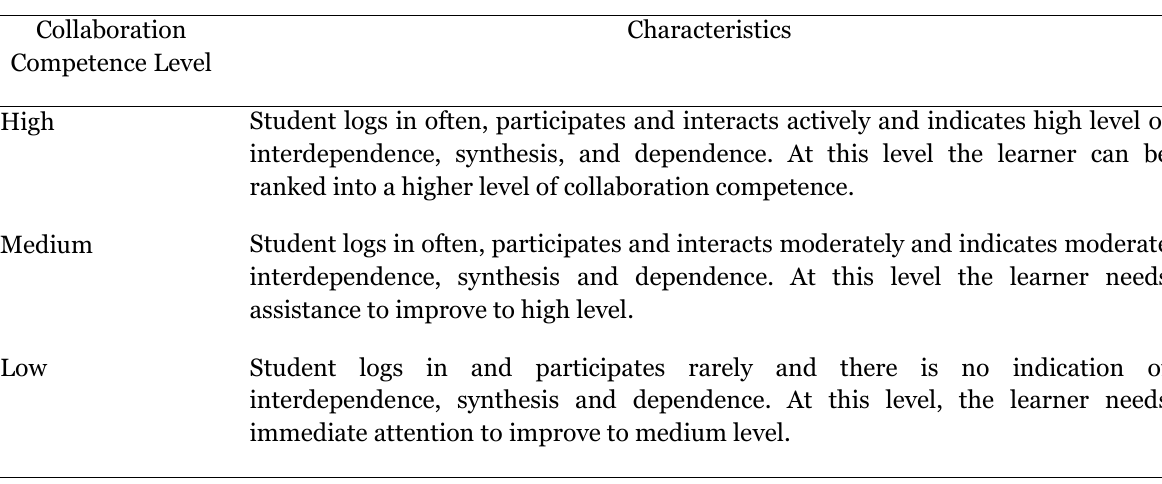
Characteristics